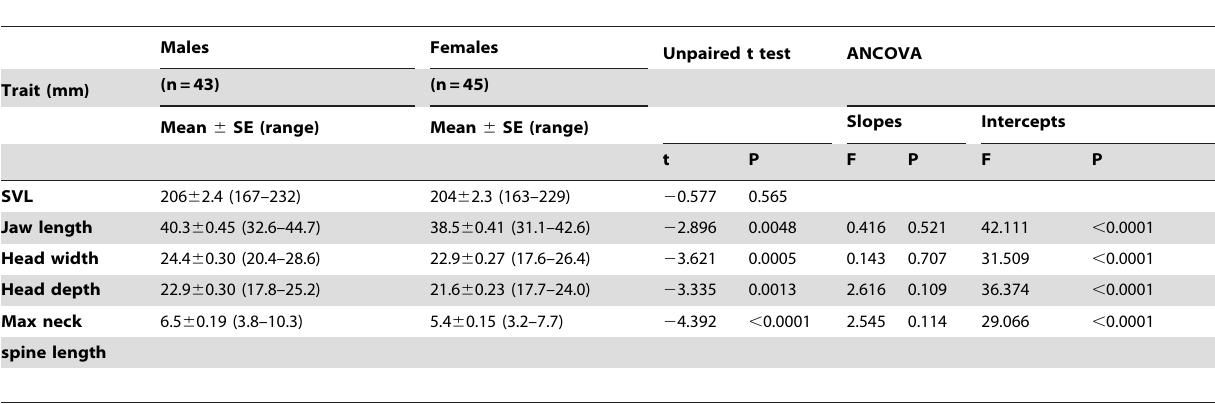
Table 1. Analyses of sexual dimorphism in adult B.